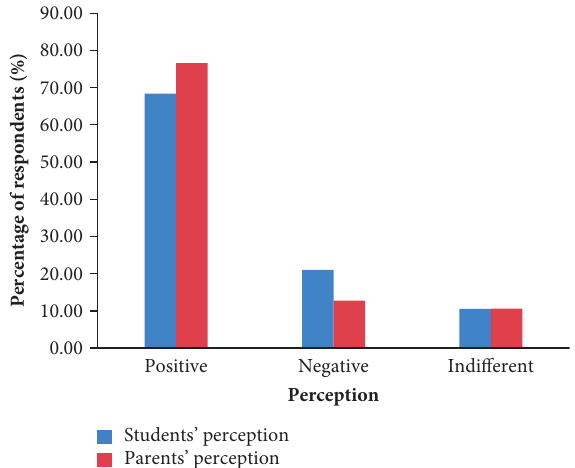
Figure 8: Societal perceptions towards S&T